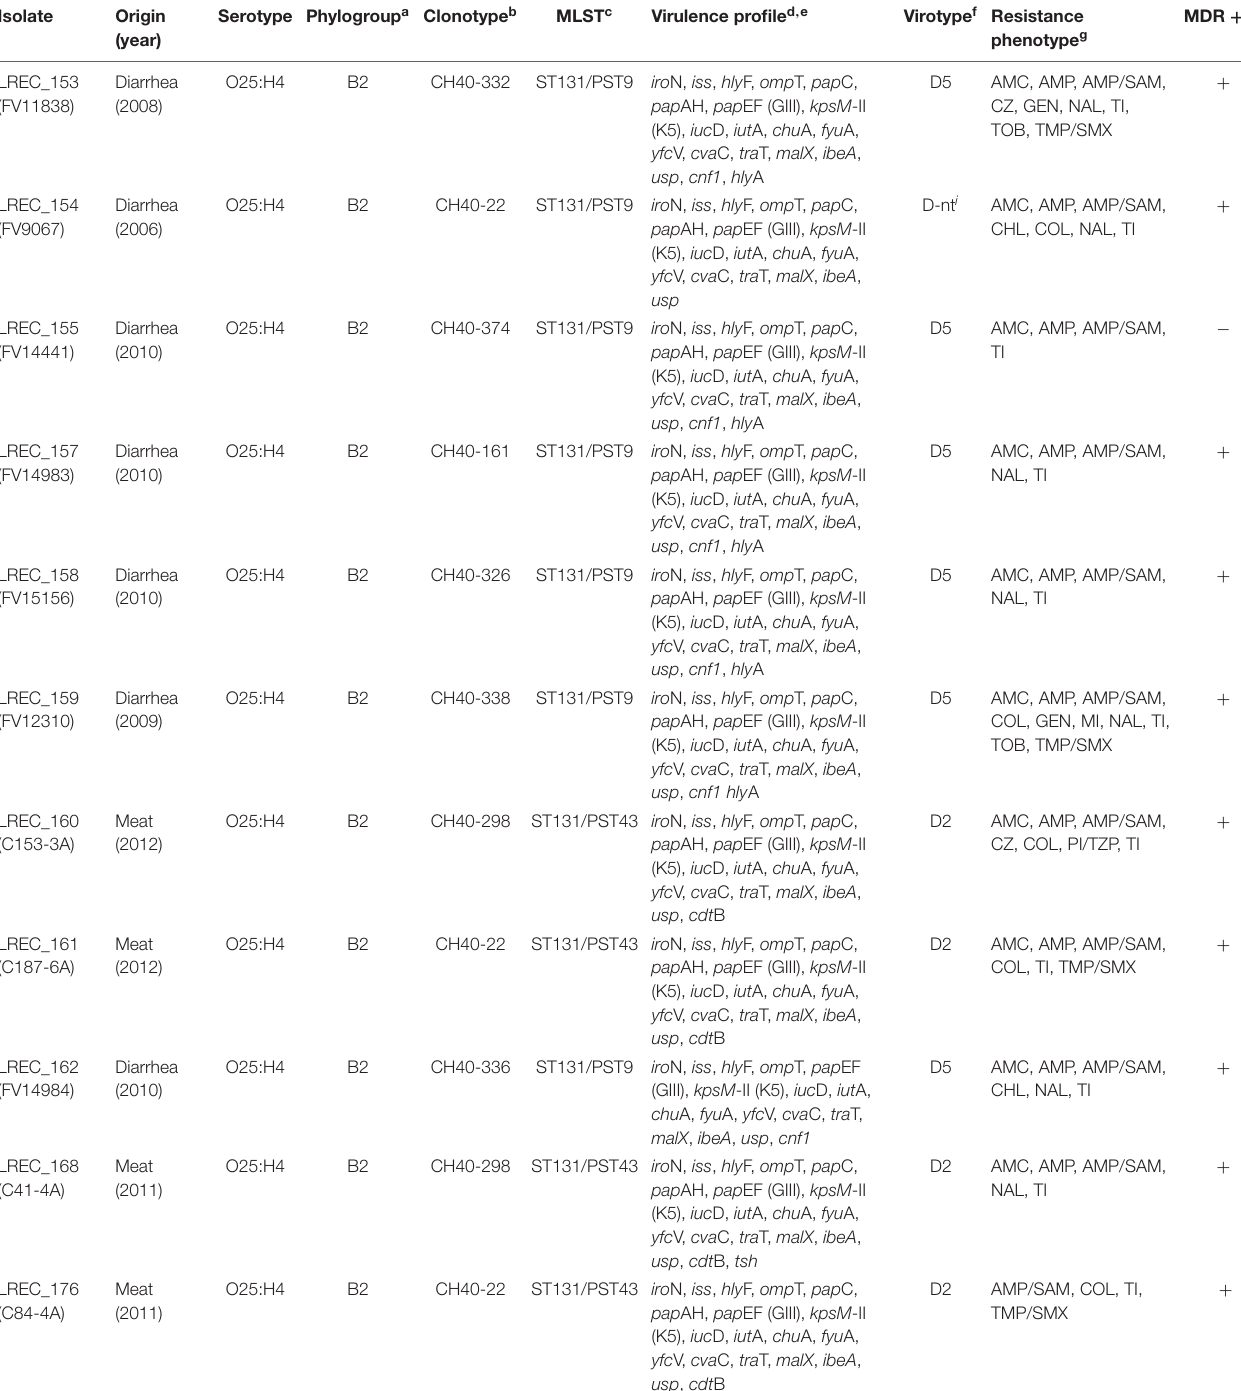
TABLE 1 | Features, molecular typing, virulence, and resistance profiles of ST131 Escherichia coli isolates from porcine origin. Isolate Origin Serotype Phylogroup a Clonotype (year)